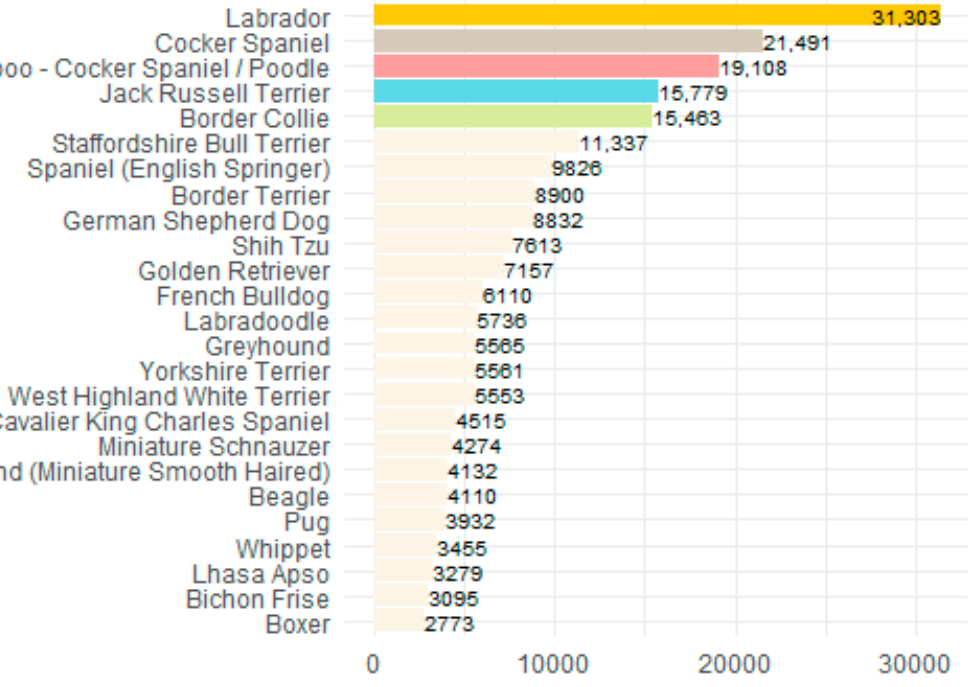
Figure 1. Population structure based on age, sex and neuter status of dogs in the UK.